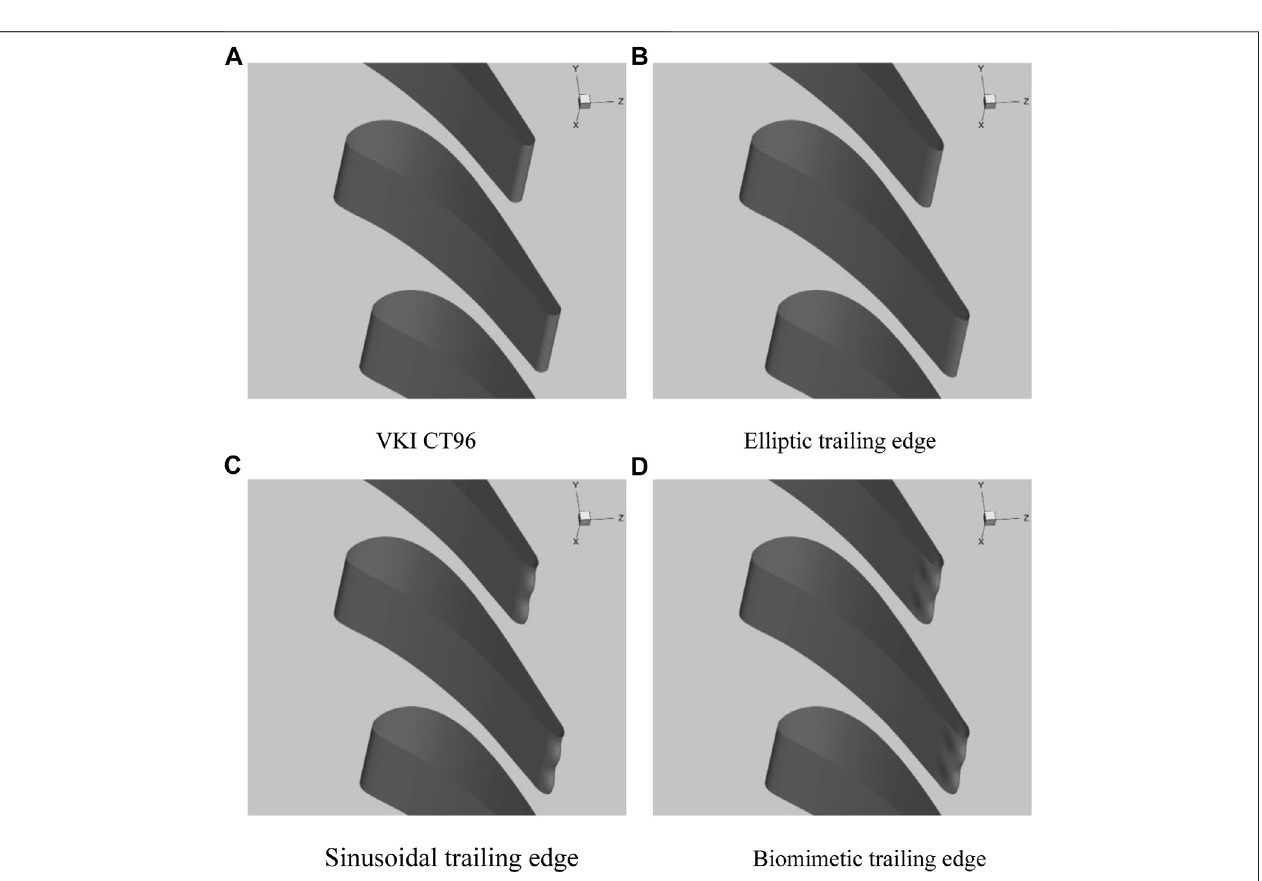
FIGURE 2 | The three-dimensional view of the four cascades. (A) VKI CT96 (B) Elliptic trailing edge. (C) Sinusoidal trailing edge (D) Biomimetic trailing edge.